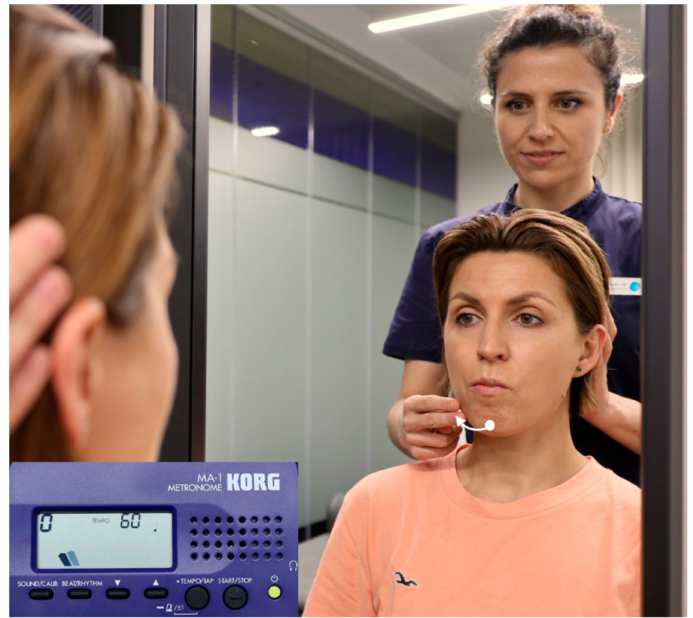
Figure 7. Masticatory training. Mandibular movements to the non-habitual masticatory side should be trained during mastication at a rhythm of 60 bpm controlled by a metronome. Perform in front of a mirror to have a visual feedback for both the patient and physiotherapist. Tactile stimuli, to indicate the side towards where the mandibular movement should be performed; may be applied if the patient has difficulties for performing the lateral